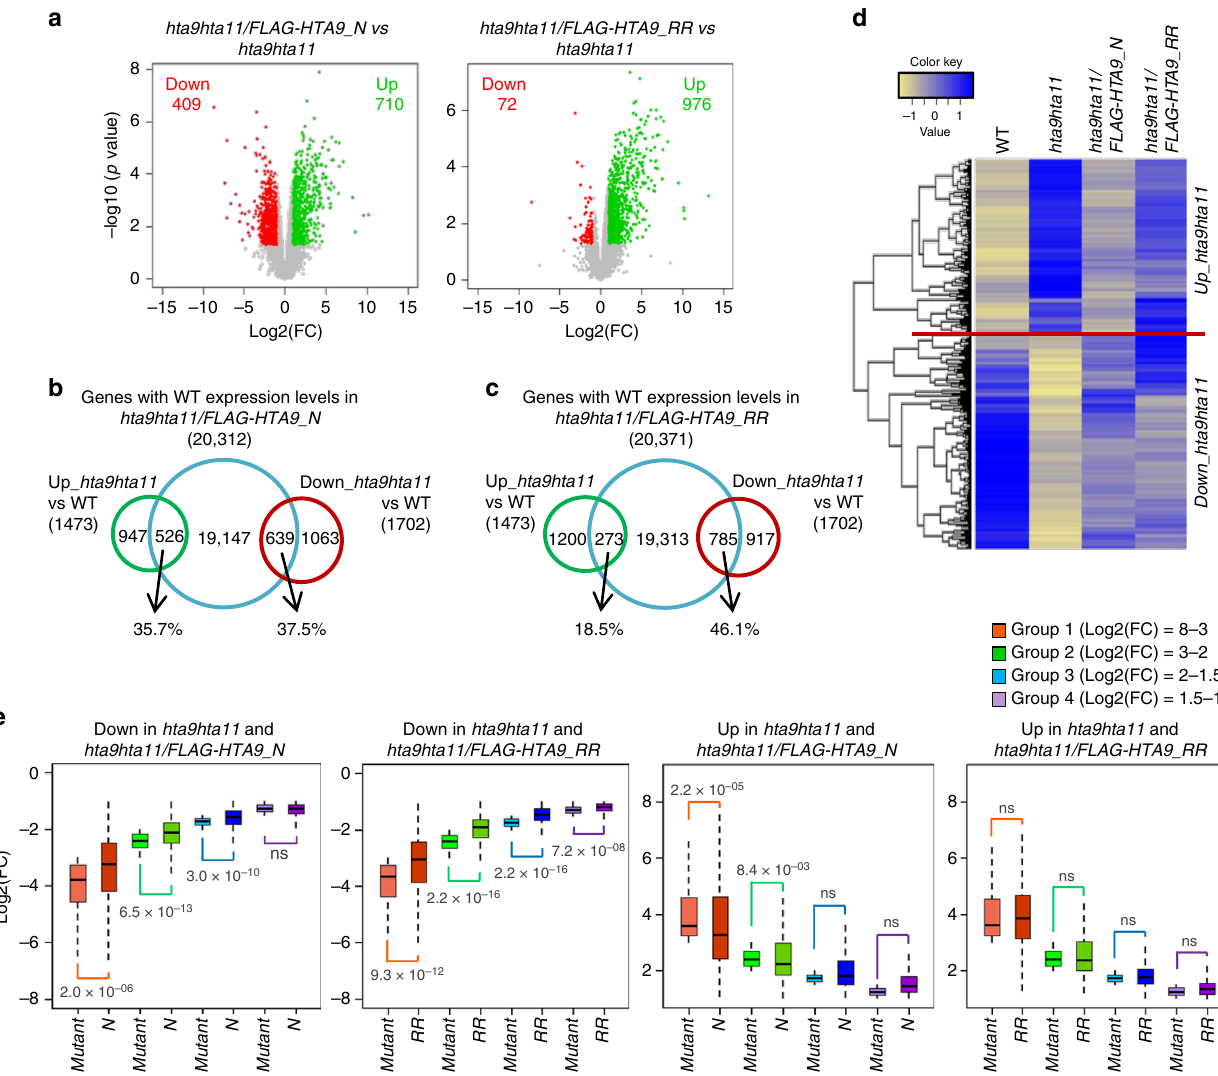
Fig. 4 H2A.Z monoubiquitination has a repressive role in gene regulation. a Volcano plots showing downregulated (left, red dots) and upregulated (right, green dots) genes in hta9hta11/FLAG-HTA9_N (left panel) or hta9hta11/FLAG-HTA9_RR (right panel) compared to hta9hta11 . b , c Comparison of the genes upregulated and downregulated in hta9hta11 according to wild-type (WT) levels and the genes with WT expression levels in hta9hta11/FLAG-HTA9_N ( b ) or hta9hta11/FLAG-HTA9_RR ( c ). The percentages of upregulated and downregulated genes in hta9hta11 that recovered WT expression levels in each line are indicated. d Heatmap representing the expression levels of the genes misregulated in hta9hta11 in different genotypes. Color code represents normalized expression values measured in FPKM (fragments per kilobase of exon and million mapped reads) (pale yellow is the lowest and dark blue the highest expression levels). A standard normalization of the gene expression pro fi les was performed to obtain a mean expression of 0 and a standard deviation of 1 in order to make the expression pro fi les comparable. e Box plots showing differential expression (DE, log2-fold change) relative to WT of the genes commonly upregulated and downregulated in hta9hta11 and hta9hta11/FLAG-HTA9_N or in hta9hta11 and hta9hta11/FLAG-HTA9_RR . Upregulated or downregulated genes in hta9hta11 were divided into four groups (200 – 300 genes in each group) according to their DE and compared to the DE that they displayed in hta9hta11/FLAG-HTA9_N or hta9hta11/FLAG-HTA9_RR . In each case, the median (segment inside rectangle), upper and lower quartiles (boxes), and minimum and maximum value (whiskers) were indicated. p Value according to Wilcoxon test of signi fi cant differences between mutant and hta9hta11/